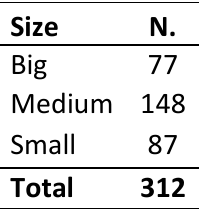
Table 1. Size of target